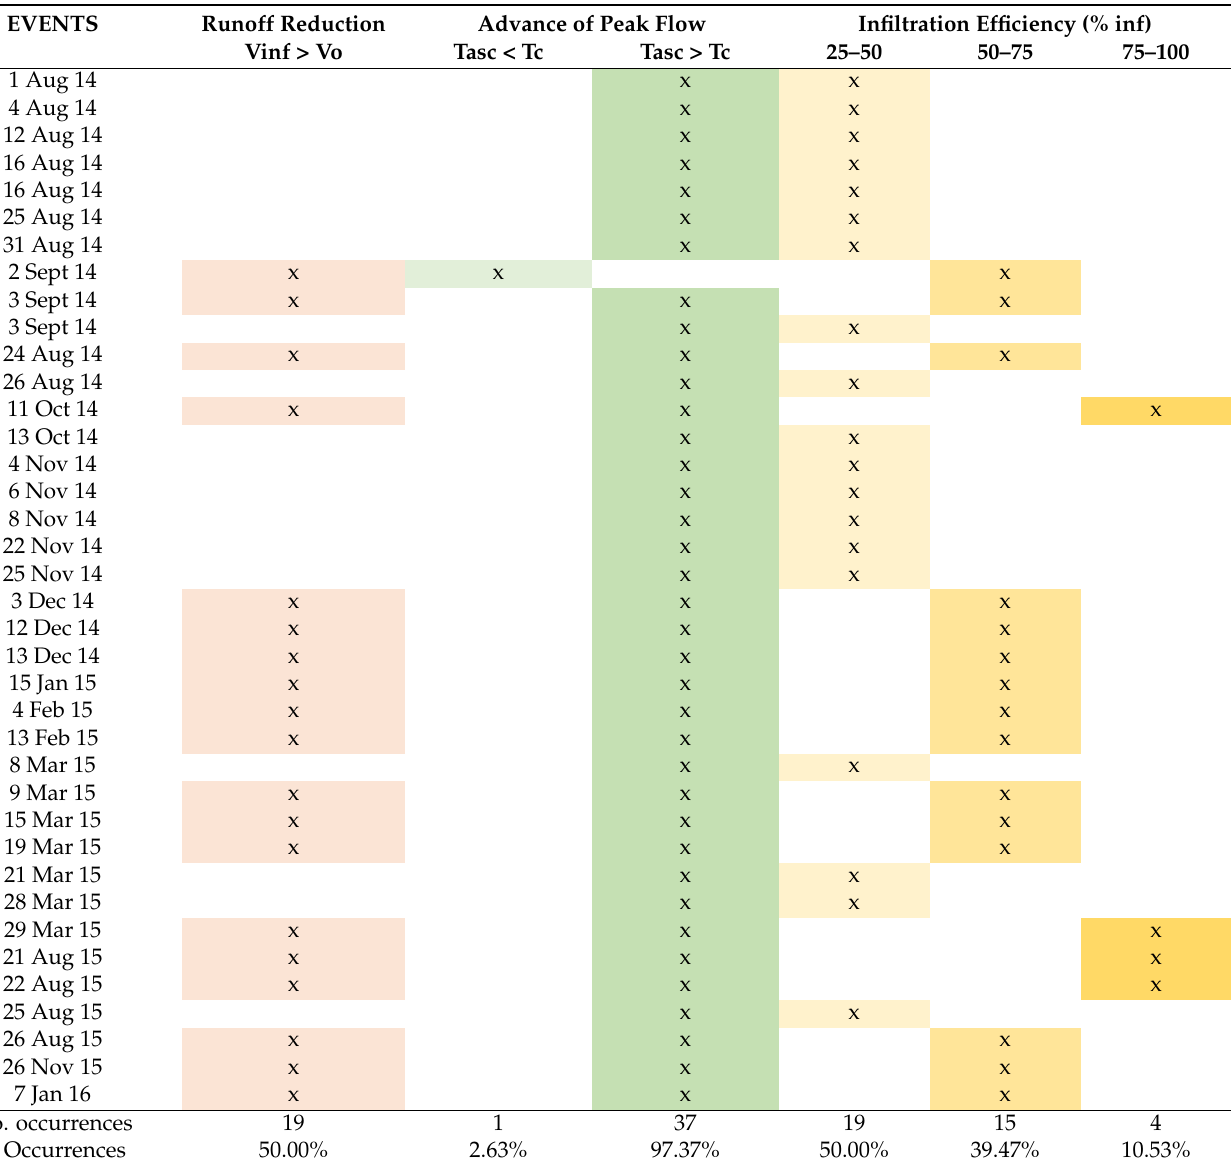
Table 2. Overall swale performance in controlling runoff.